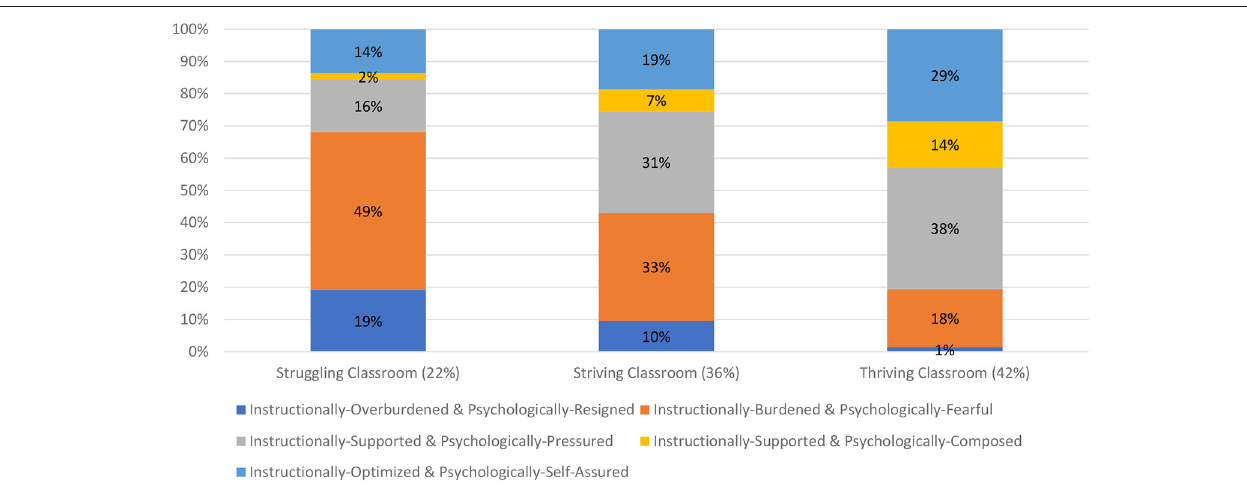
FIGURE 3 | Multi-level LPA results showing the classroom-level instructional-psychological profiles.